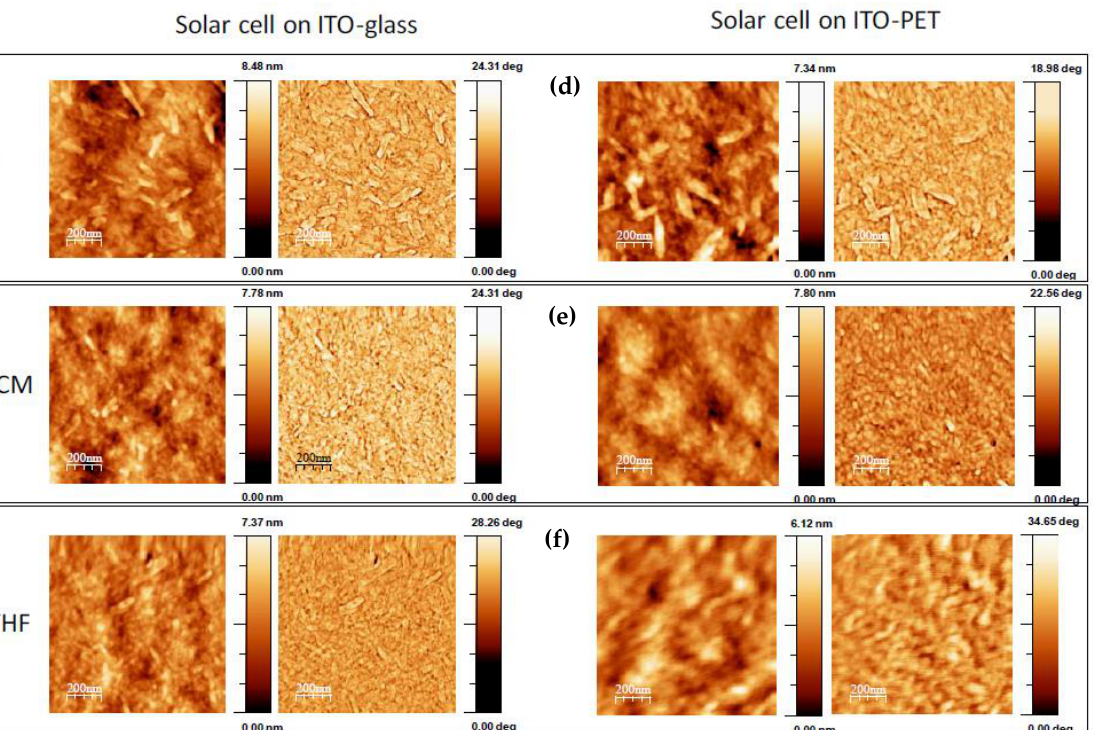
Table 3. Cell parameters of devices treated by SVA in DCM solvent at different exposure times. SVA Exposure Time (min)